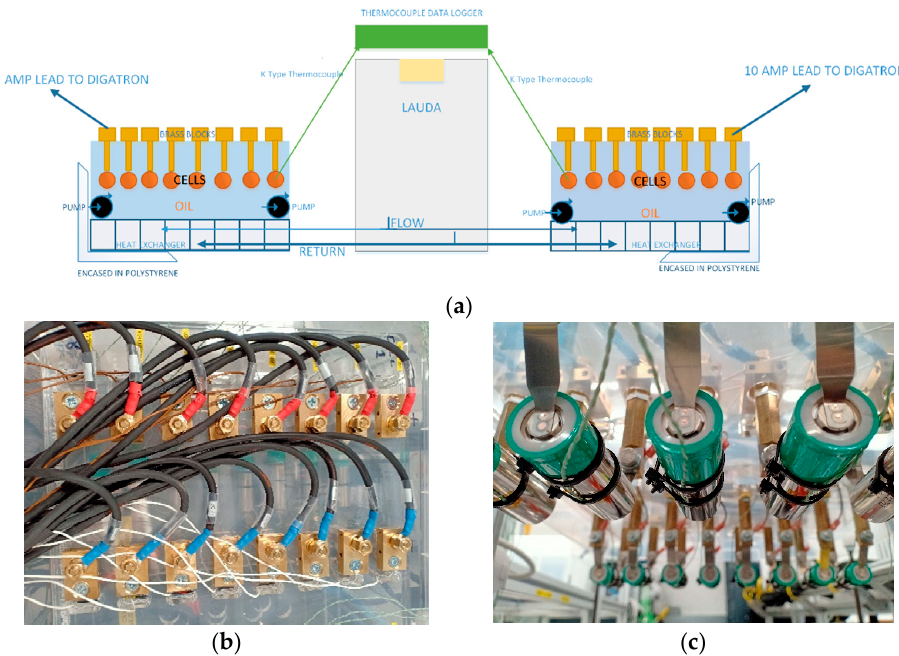
Figure 3 . Experiment setup ( a ) the schematic diagram. ( b ) top view of the real setup. ( c ) cells inside the setup.